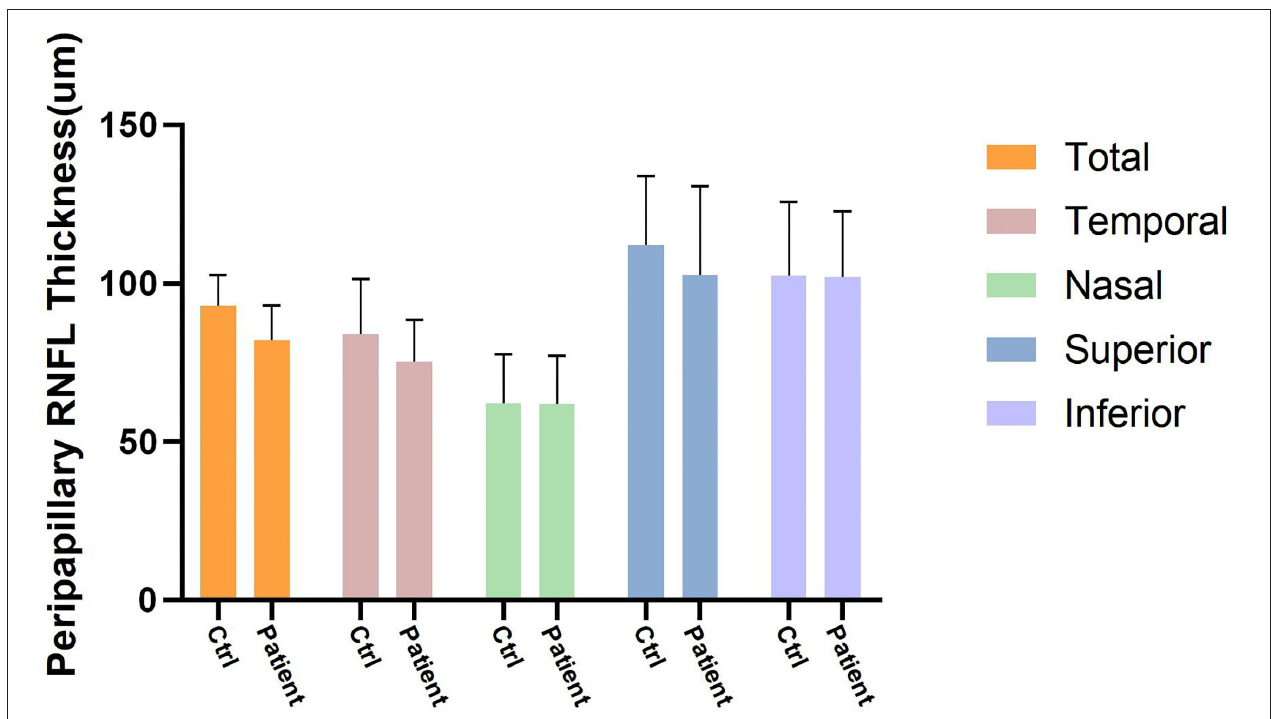
FIGURE 5 | Four quadrants of pRNFL thickness changes ( µ m) between control group and prediabetes group.